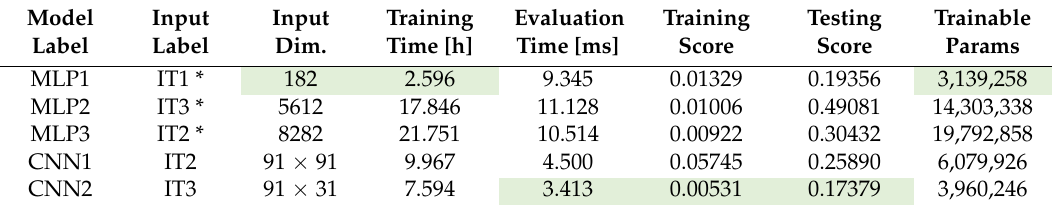
Table 2. Performance measures of NN-based models concerning different NN architectures and input data types.